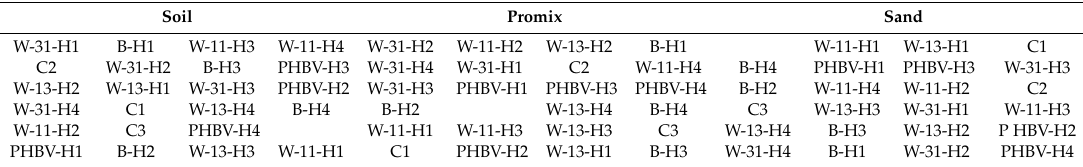
Table 3. Experimental layout showing blocks and location of